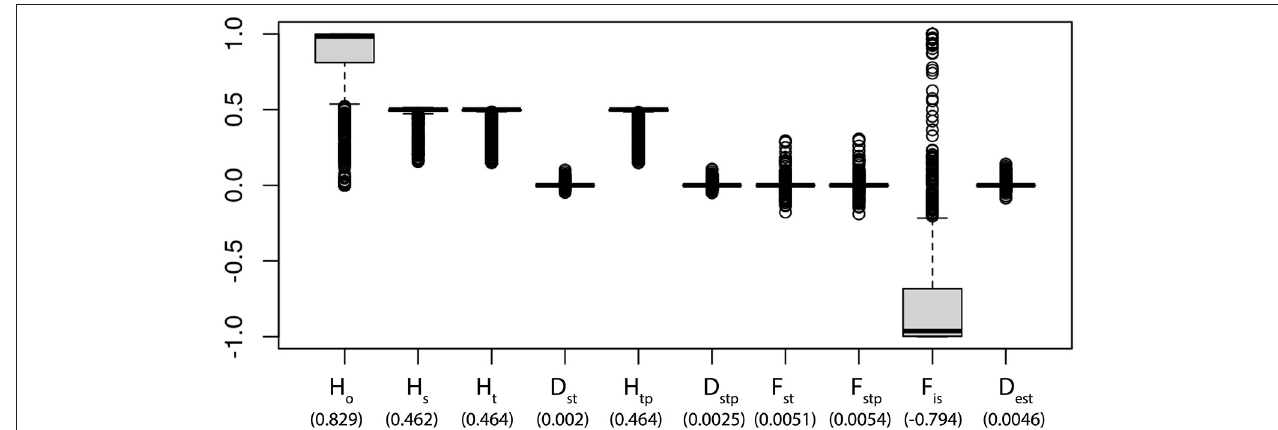
FIGURE 2 | Summary statistics of genetic variation existing in Panax vietnamensis by 1,181 SNPs. The vertical line = median; boxes show quantiles; and points show outliers. H O , heterozygosity within population; H S , genetic diversity within population; H T , overall gene diversity; H TP , corrected H T ; D ST , gene diversity among samples; D STP , corrected D ST ; F ST , fixation index; F STP , corrected F ST ; F IS , inbreeding coefficient per overall loci; D EST , measure of population differentiation. Numbers in parentheses below each category indicate the average value.